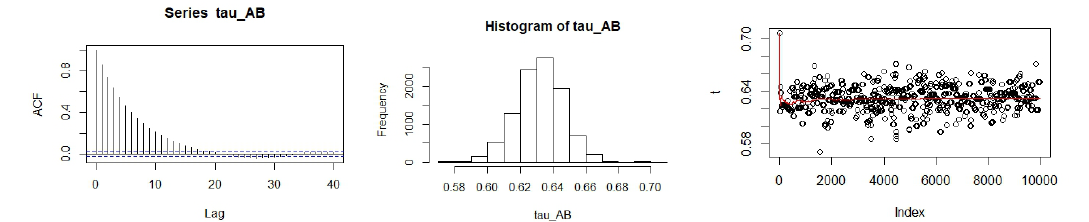
Figure 3. Autocorrelation function, histogram of posterior and trace plot for AB (Model